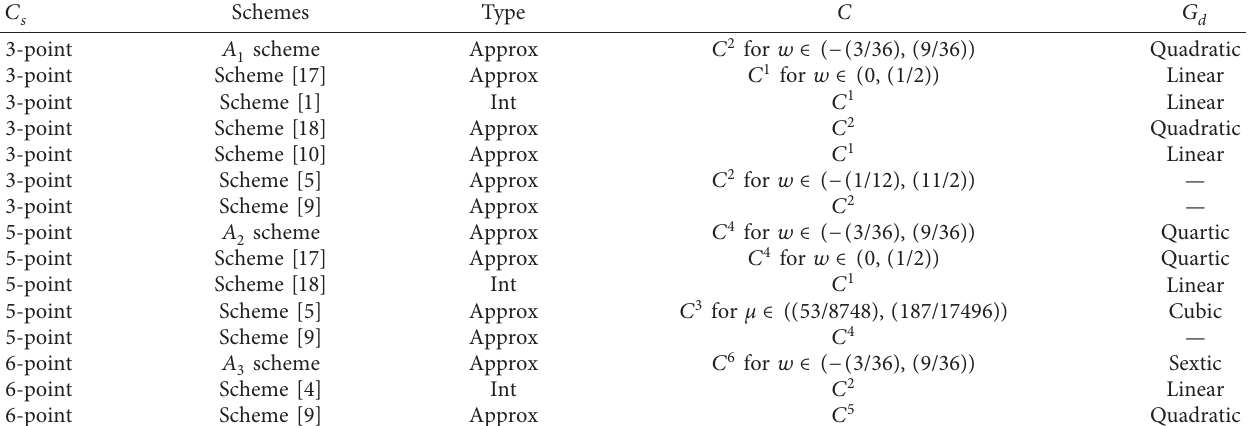
Table 1: The comparison of a family of ternary schemes S of subdivision schemes,